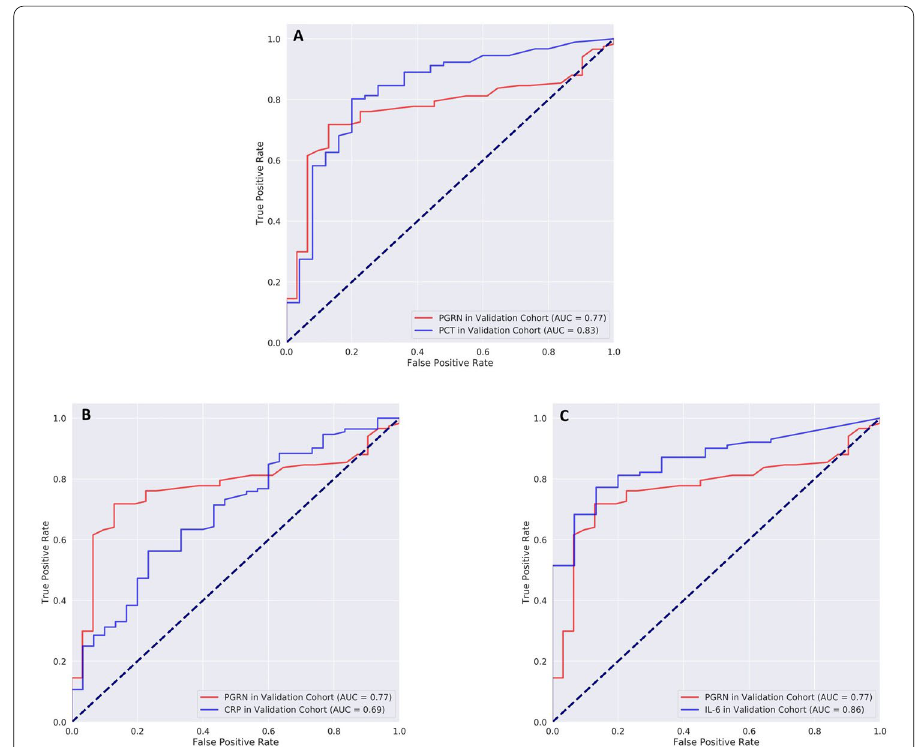
Fig. 7 ROC curves for the differentiation between patients with community‑acquired pneumonia (CAP) and patients with sepsis in the validation cohort. Red lines indicate ROC curves for progranulin in all graphs and blue lines the corresponding values for procalcitonin (PCT, A ), C‑reactive protein (CRP, B ) and interleukin‑6 (IL‑6, C ). Cut‑off values and data for sensitivity/specificity for the reference biomarkers in comparison to progranulin are given in Additional file 1: Table